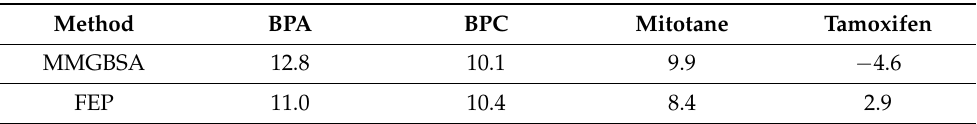
Table 1. Binding free energies in kcal/mol of different ligands with ER-α expressed as differences with respect to the value of E2.